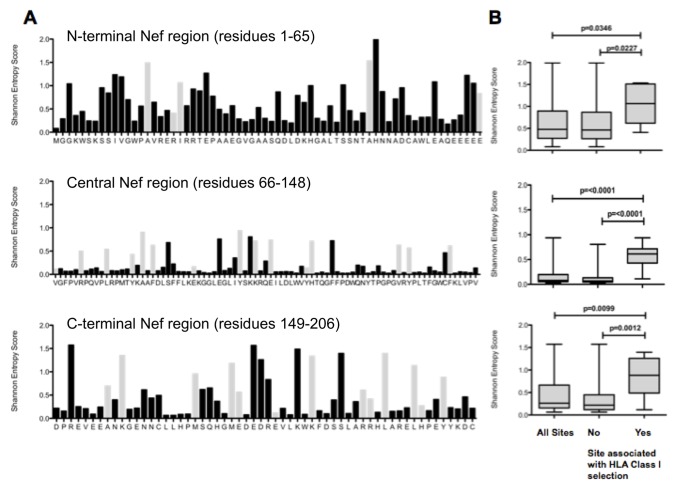
Variation in C-clade Nef sequences, and relationship between amino acid variability and presence of HLA-class I selection pressure.[A] Nef consensus sequence (derived from 739 C-clade sequences from Southern African patients) plotted against Shannon entropy score. Residues at which there is an association with HLA-Class I expression are shown in grey. As previously observed, the sequence is most highly conserved in the central portion of the protein (residues 66-148) [8]..[B] Entropy scores of residues associated with HLA-class I expression vs. those with no HLA association, showing significantly higher variability at sites at which HLA selection operates, particularly in the central conserved region. P-value by Mann Whitney U test.